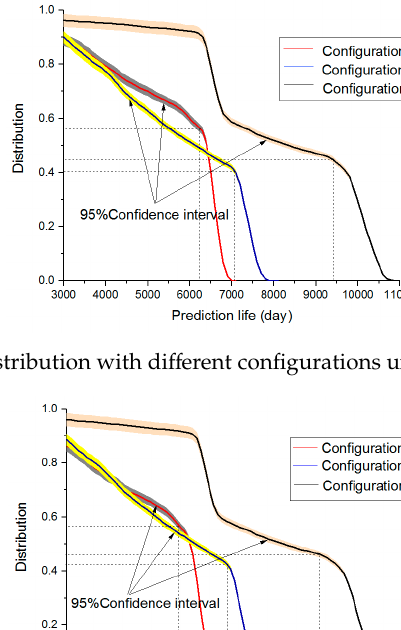
Figure 19. Life distribution with different configurations under work mode M2.